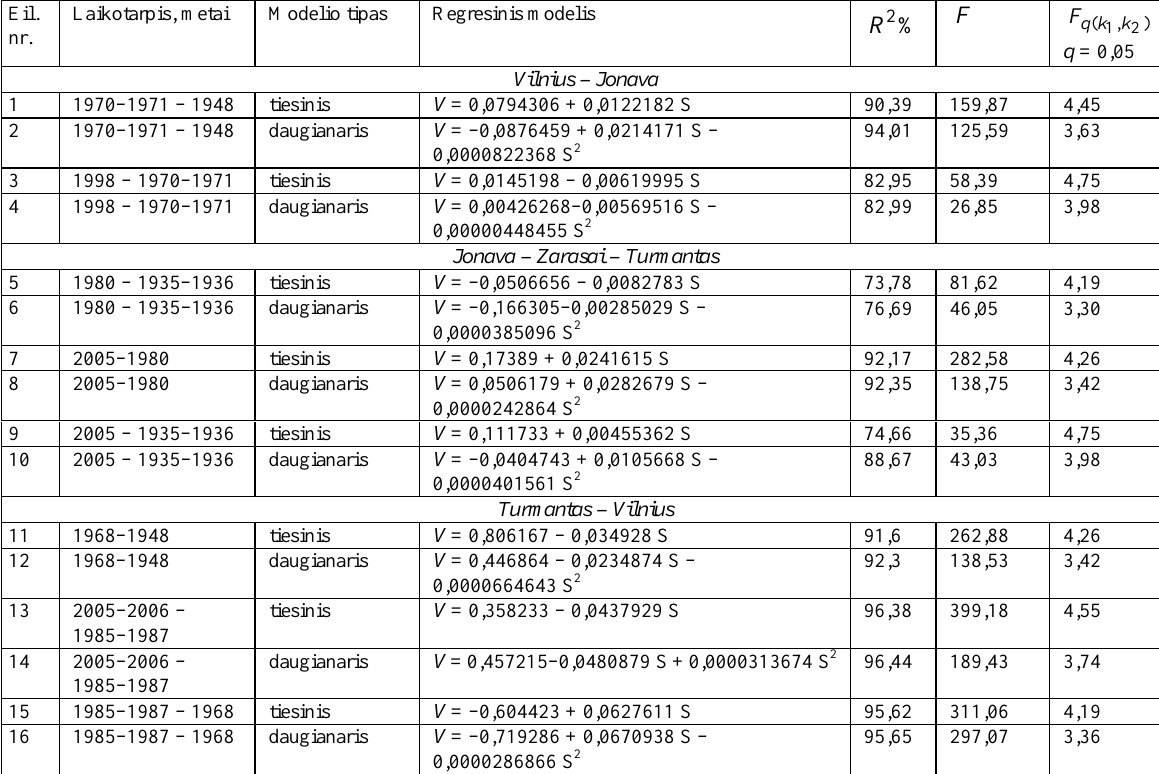
Table 1. Regressive models of Earth surface vertical movements velocities in repeated levelling lines Eil. nr.